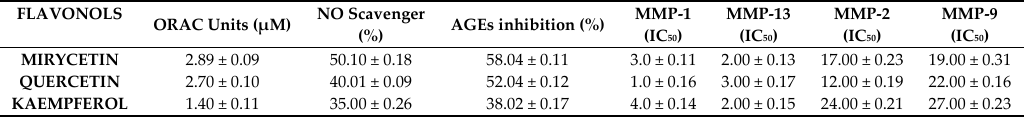
Table 2. Antioxidant and anti-glycation activity of flavonols. Data were expressed as mean ±SD of three